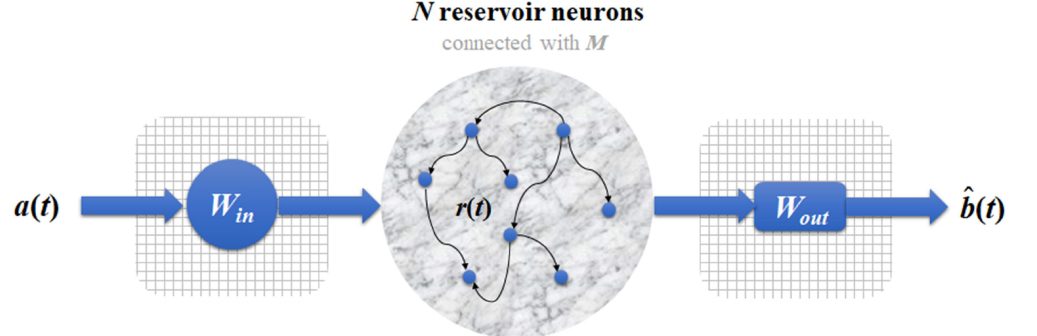
Figure 2. Schematic of the RC neural network: the three layers are the input layer, reservoir layer, and output layer. The input layer consists of a matrix W in . The reservoir layer consists of N reservoir neurons whose connectivity is through the adjacent matrix M , and r ( t ) denotes the activation of neurons. The output layer consists of a matrix W out ; a ( t ) and ˆ b ( t ) denote the input and output time series.